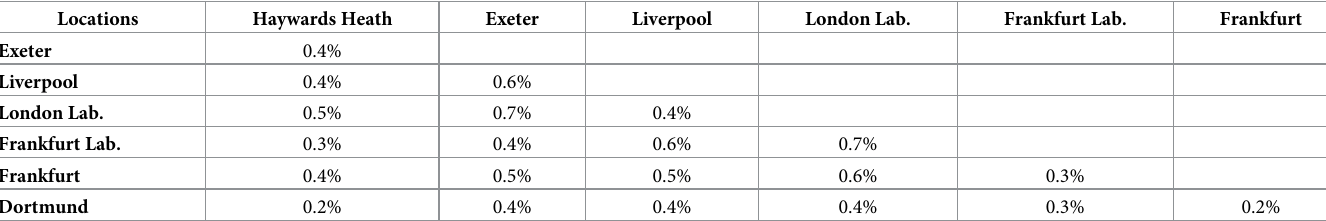
Table 6. Estimates of evolutionary divergence over sequence pairs between groups of C . vicina from the seven trapping locations.